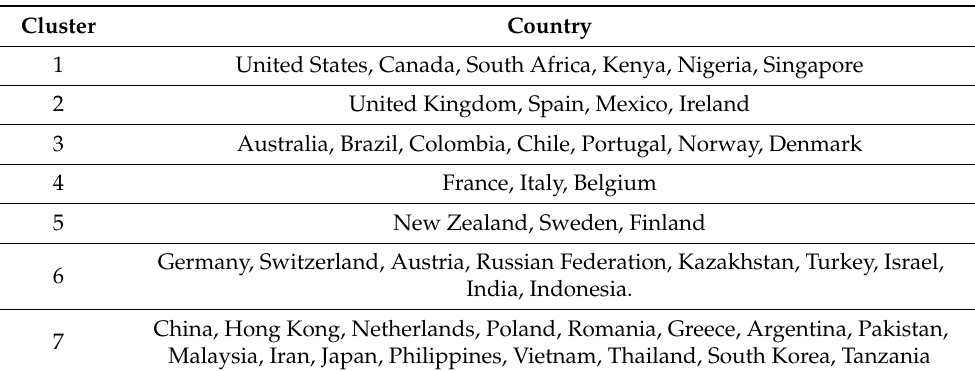
Table 7. Co-authorship analysis at the country level. (7 clusters; 48 countries).